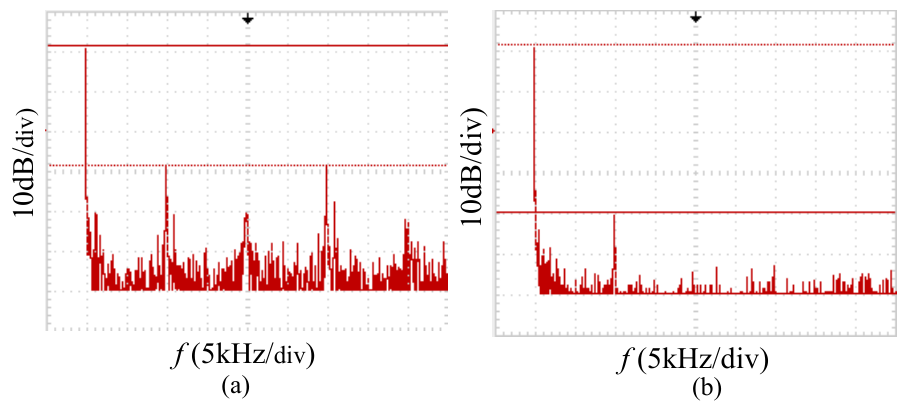
Figure 16. FFT of the current in phase N ( a ) converter-side ( b ) grid-side.